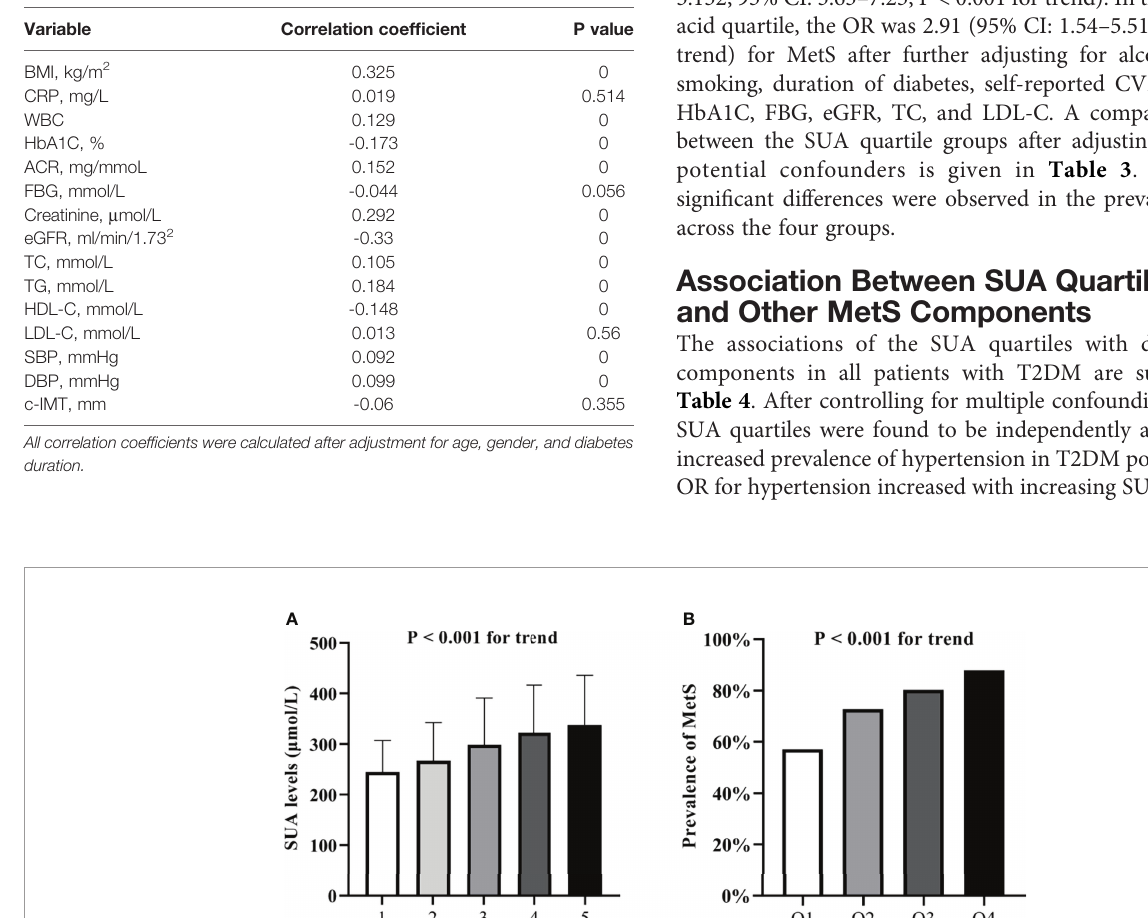
TABLE 2 | Correlation between SUA and other parameters.